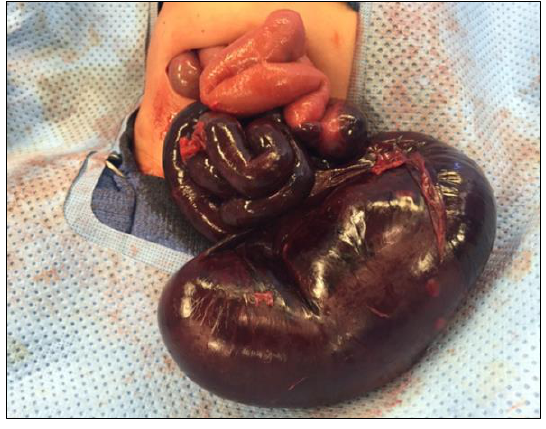
Figure 1: Jejunal atresia with dilated, necrotic proximal end. The patient was transferred to the neonatal intensive care unit post-operatively where he had an uneventful recovery. Within 2 weeks he was tolerating full oral feeds, having good ostomy function, and weaned from parenteral nutrition. His anoplasty healed well and he was started on dilations. He underwent an ostomy reversal with primary jejunoileal anastomosis 6 weeks after his jejunostomy creation. Today, the patient continues to tolerate full oral feeds and is having normal